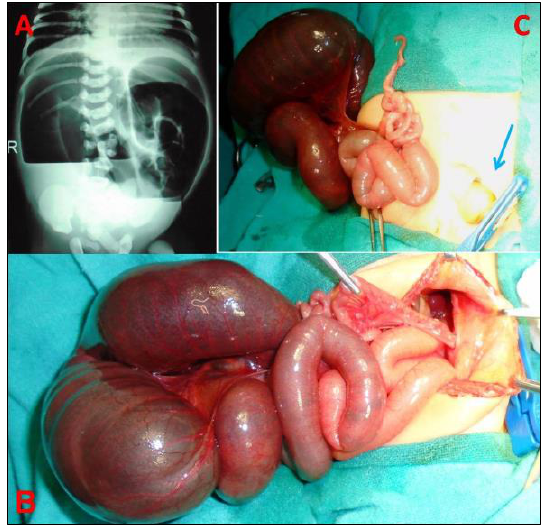
Figure 1: Upright abdominal radiograph showing dilated small bowel loops, multiple air-fluid levels with absence of air distally (A); Intra-operative picture showing type IIIa ileal atresia with distal unused ileum is seen herniating into the umbilical cord (B); hernia of umbilical cord (blue arrow) is seen along with proximal part of distal ileum after its dissection from inside the sac